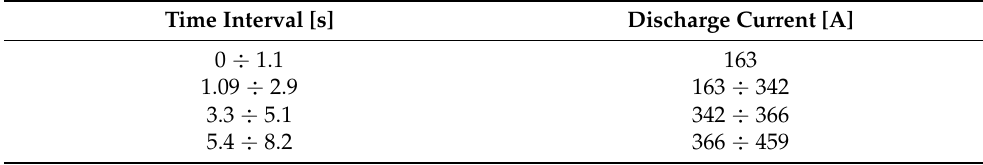
Figure 7. Discharge current during 0–200 km/h full power acceleration in hybrid mode. Table 3. Discharge current of the battery pack during 0–200 km/h acceleration simulation test. Time Interval